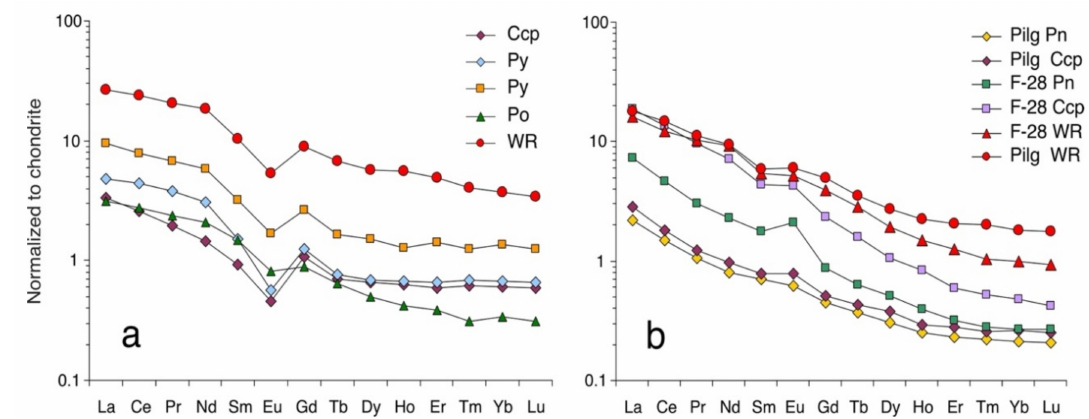
Figure 5. REE distribution in a rock (WR) and sulfide minerals from Cu-Ni-PGE complexes of Fennoscandian Shield: 2.44 Ga Penikat intrusion ( a ) and 1.98 Ga Pilgujärvi deposit (Pechenga) ( b